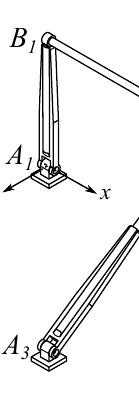
Figure 8. A vertical configuration for a limb belonging to the closed loop H 1